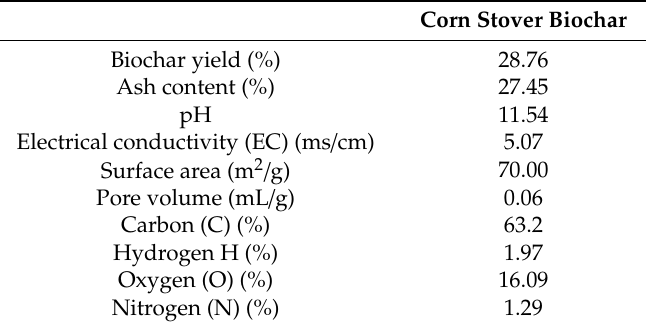
Table 1. Basic parameters of the used corn stover biochar.